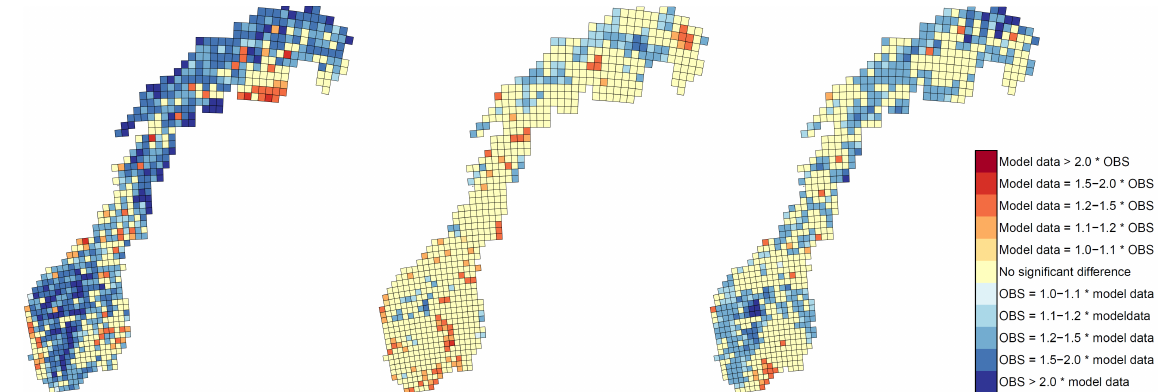
Figure 1. Fisher tests of the 95% quantile of the winter season uncalibrated dERA40 test data (left panel), the calibrated dERA40 test data (middle panel), and the calibrated dBCM test data (right panel). The plots show significance level α = 5%.